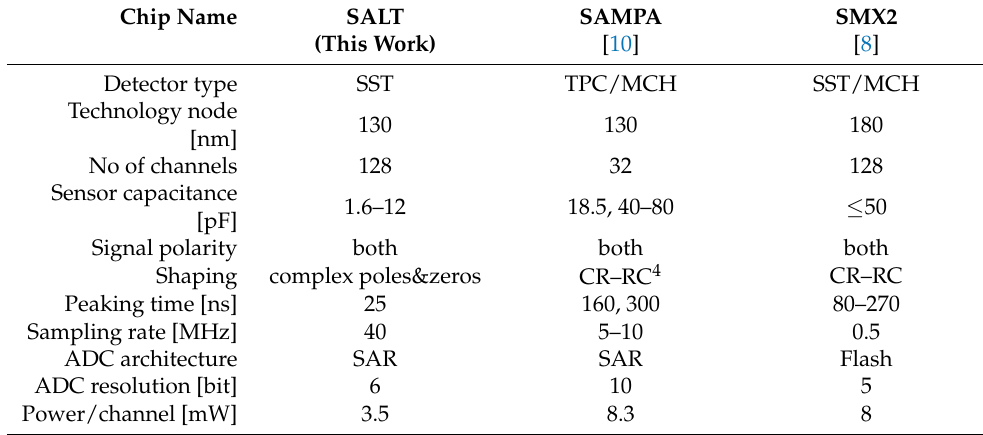
Table 3. State of the art readout ASICs for HEP experiments with on-chip per channel ADCs (SST— Silicon Strip Tracker, TPC—Time Projection Chamber, MCH—Muon